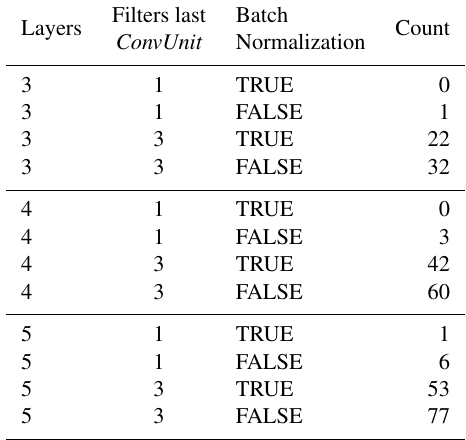
Table A1. Similar to Table 4 but grouped according to amount of layers , filters in the last ConvUnit , and batch normalization .